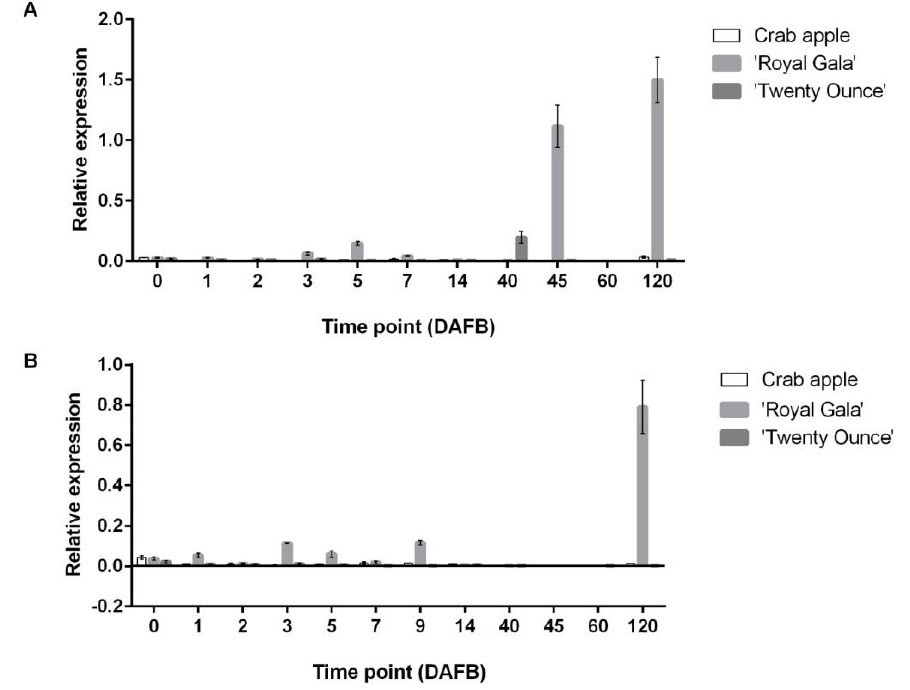
Figure 10. Differential expression of MdACO1 in three cultivars during Season 2, relative to the control gene, MdGAPDH . ( A ) Relative expression in biological Replicate 1 (Rep1). ( B ) Relative expression in biological Replicate 2 (Rep2). Error bars represent standard deviation (n = 3).